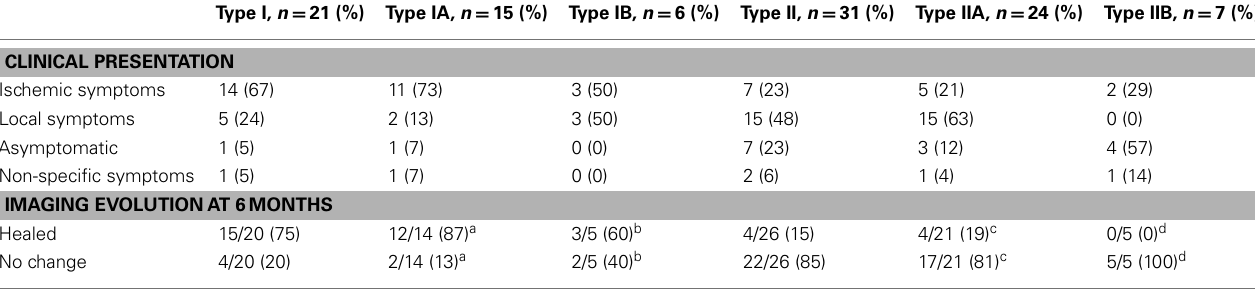
Table 2 |Type I and type II